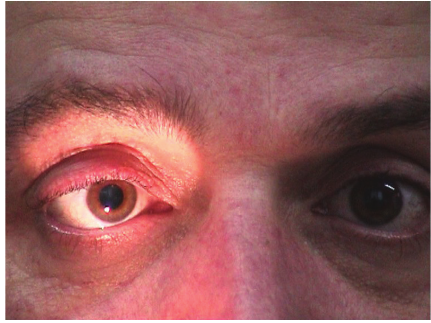
Figure 2: Bilaterally dilated pupils with absent response to light when light is shown to the right eye.